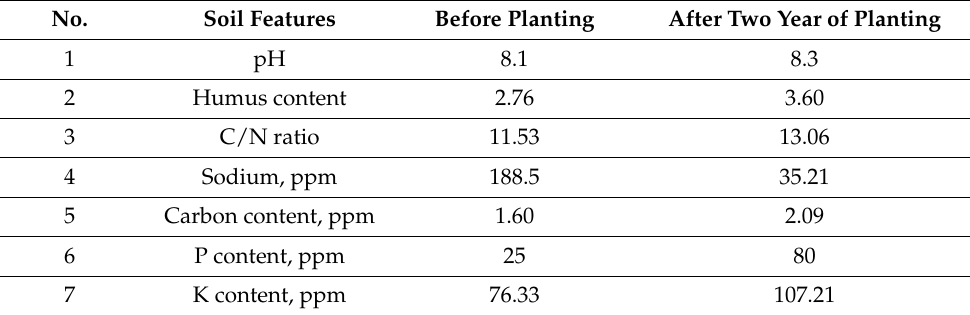
Table 1. Soil features before and after